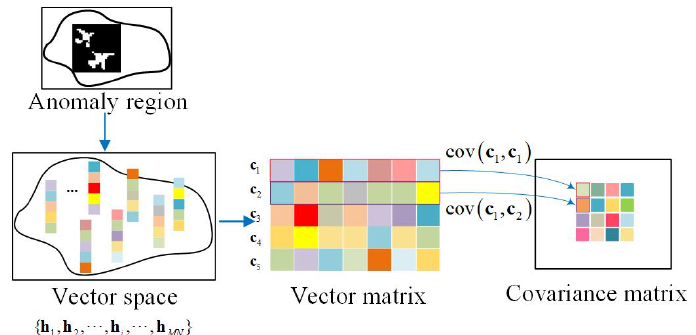
Figure 2. The progress of multi-prior construction